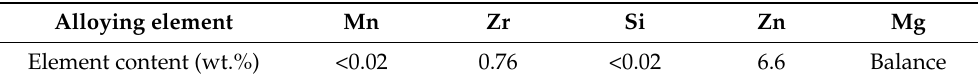
Table 1. Chemical composition of ZK61 magnesium alloy.